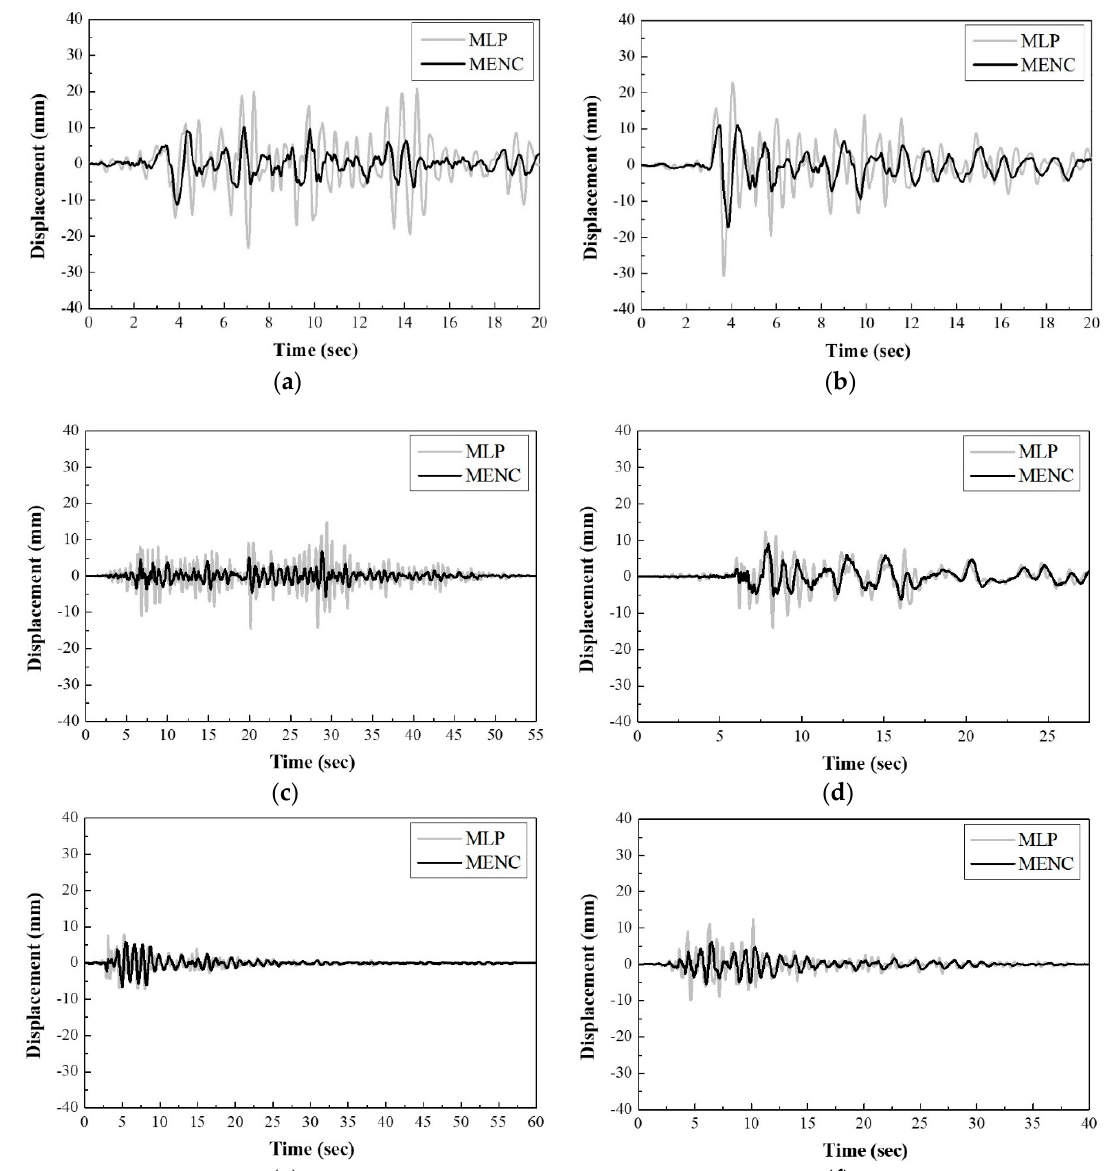
Figure 5. Seismic loads for the numerical analysis: ( a ) California earthquake; ( b ) Northridge earthquake; ( c ) Landers earthquake; ( d ) Cape earthquake; ( e ) San Simeon earthquake; ( f ) Loma Prieta earthquake.